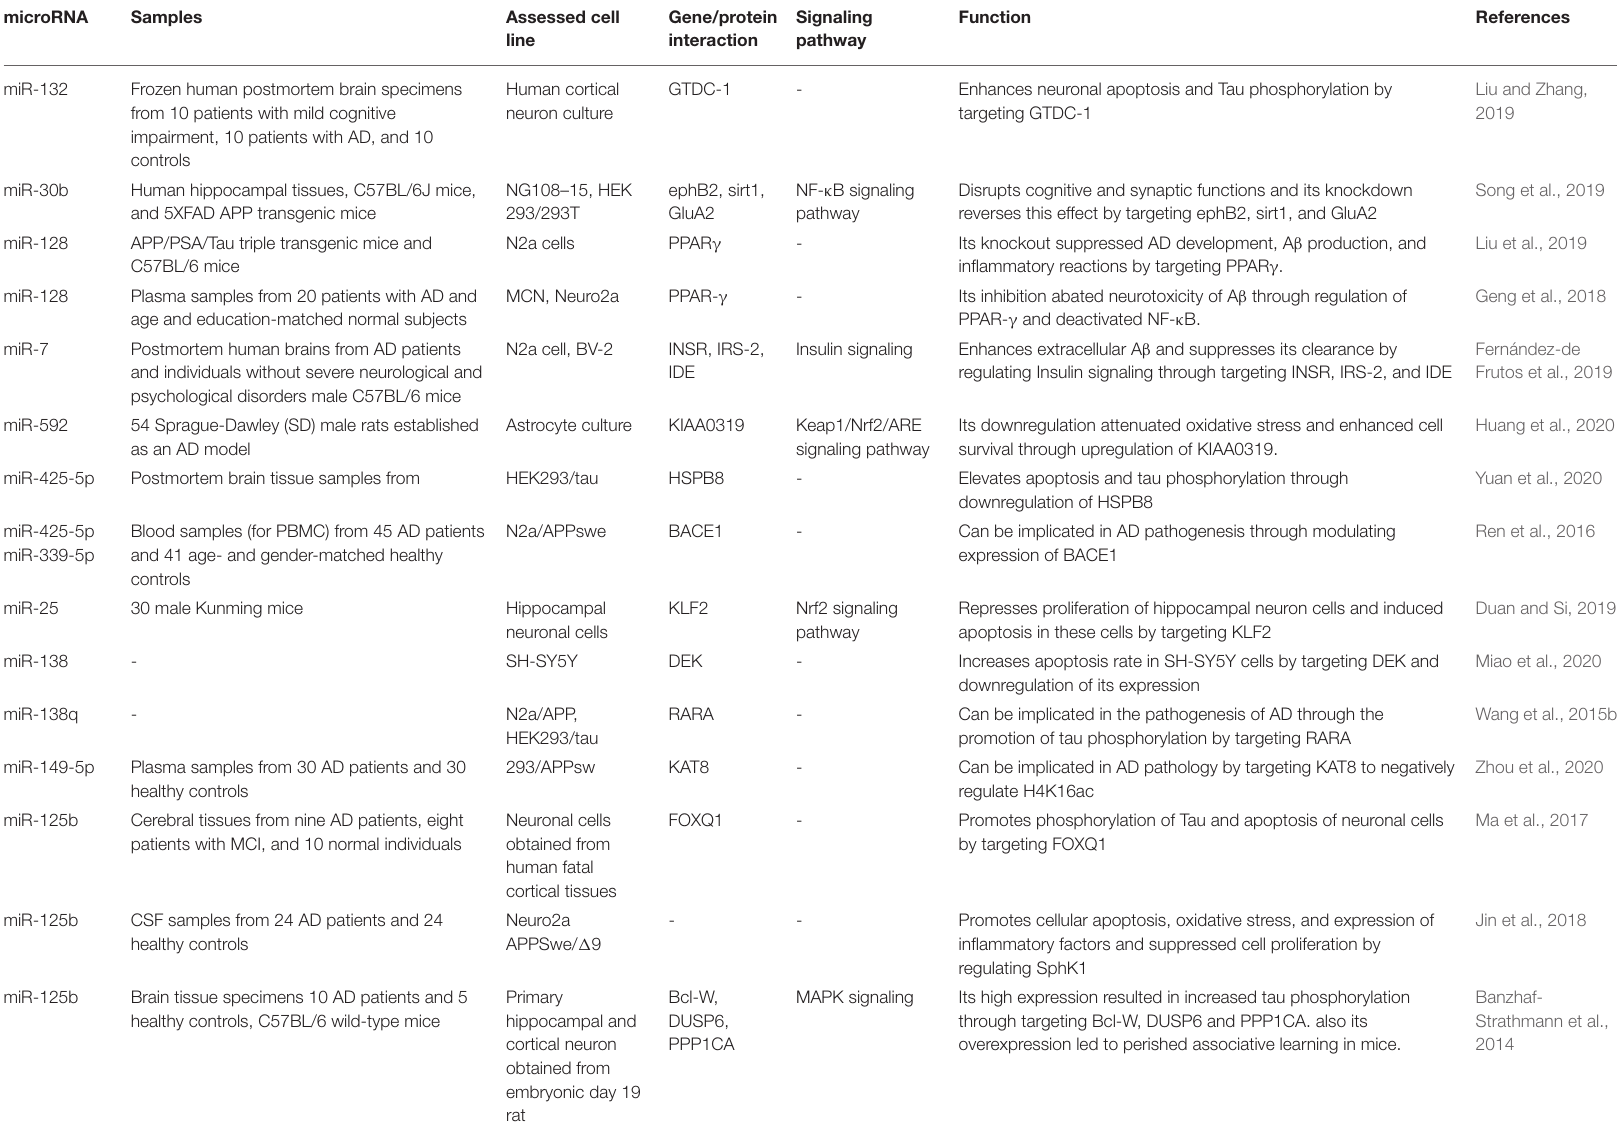
TABLE 2 | Upregulated miRNAs in AD subject, animal models of AD or related cell lines and their functions in progression of AD.